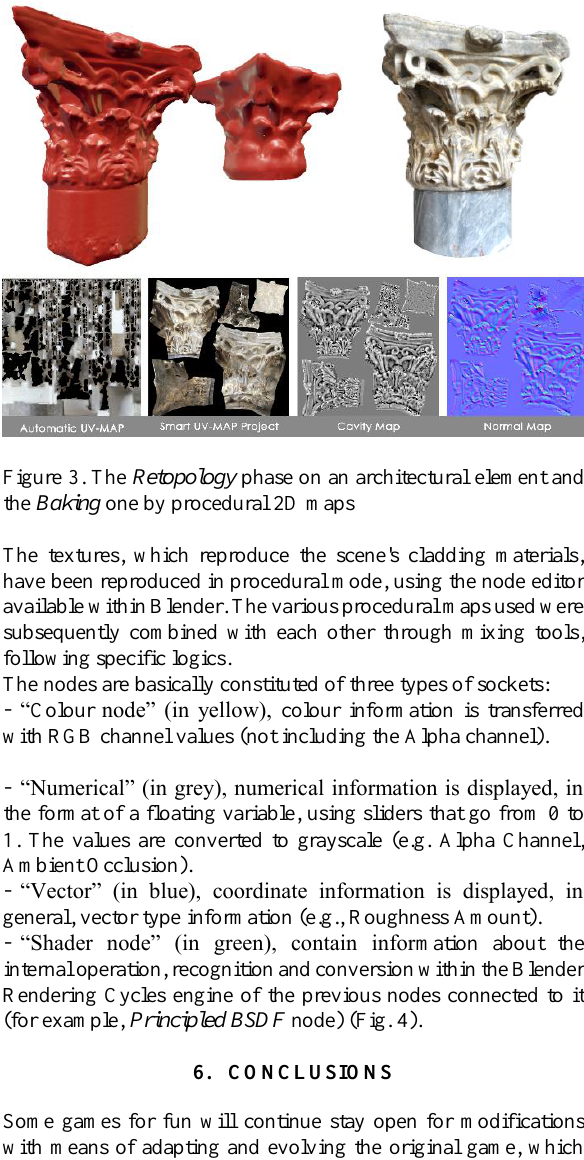
Figure 4. The procedural texture creation which reproduce the